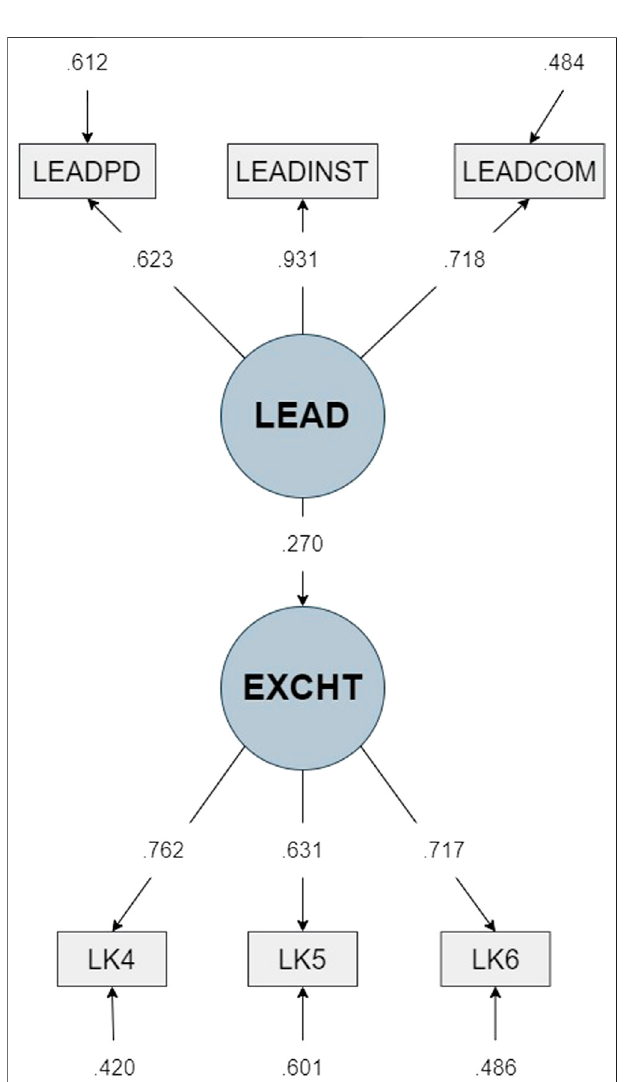
FIGURE 3 | Structural model (at school level) of IL (LEAD) and TC (EXCHT). Note: All displayed values signi fi cant at p ≤